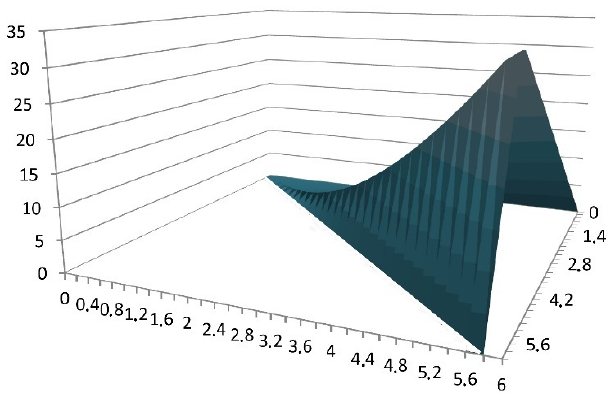
Figure 6. The surface generated by the function f ( τ (cid:48) , τ (cid:48)(cid:48) ) = τ (cid:48) τ (cid:48)(cid:48) .